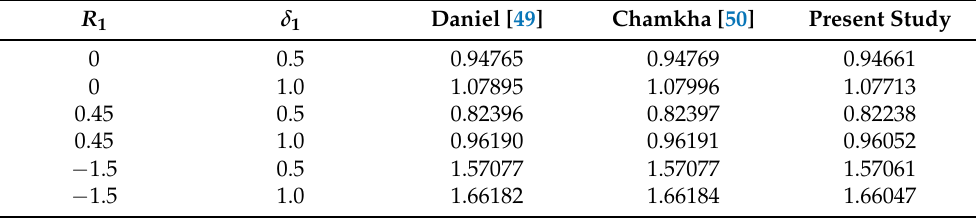
Table 4. Comparison of − θ (cid:48) ( 0 ) for R 1 and δ 1